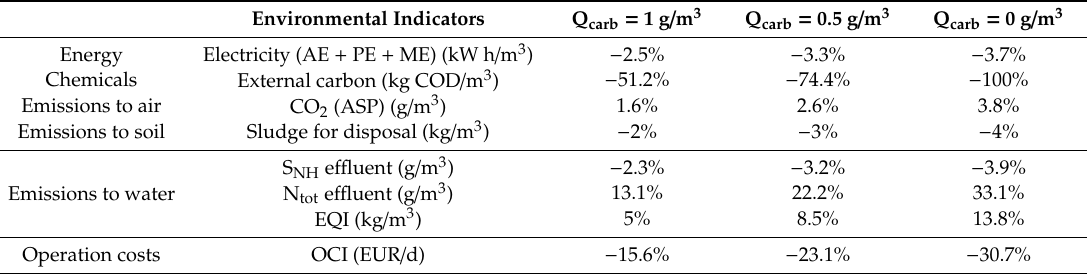
Table 10. Comparison of the influence on environmental and cost indicators of carbon dosage variations relative to default Q carb = 2 m 3 / d with the ammonium-based control (Cascade S NHSP ) with S NHSP = 1 g / m 3 .